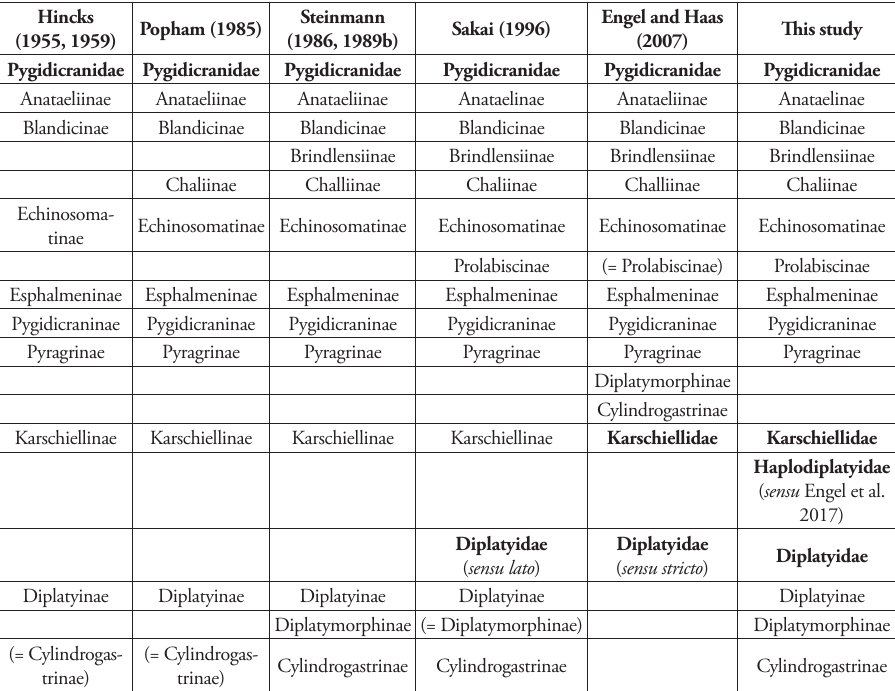
Table 1. Proposed classification systems for the infraorder Protodermaptera Zacher,